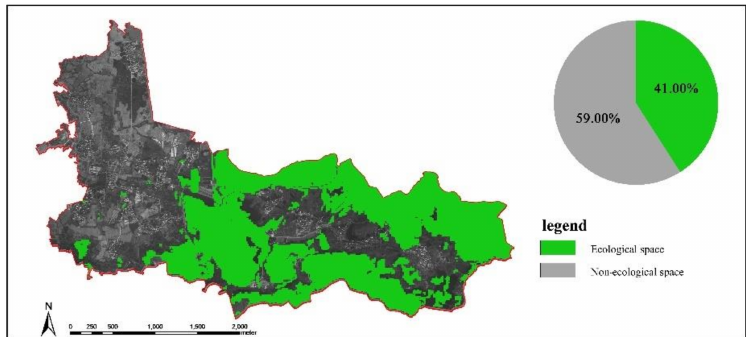
Figure 10. Ecological space in